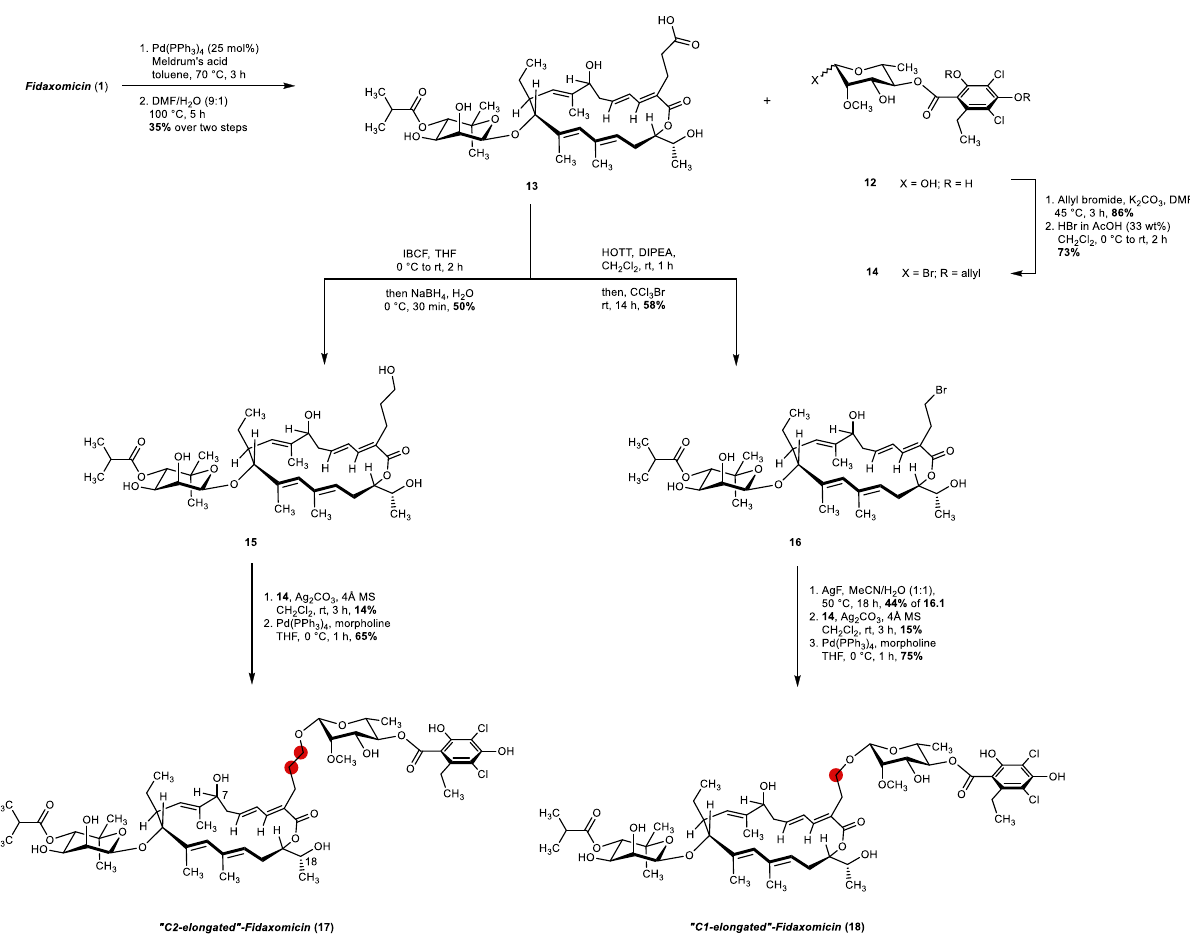
Fig. 11 Synthesis of C2- and C1-elongated fi daxomicin analogs. Detailed synthetic route toward C2- and C1-elongated fi daxomicin analogs 17 and 18 . IBCF Isobutyl chloroformate, HOTT S-(1-oxido-2-pyridinyl) − 1,1,3,3-tetramethylthiouronium hexa fl